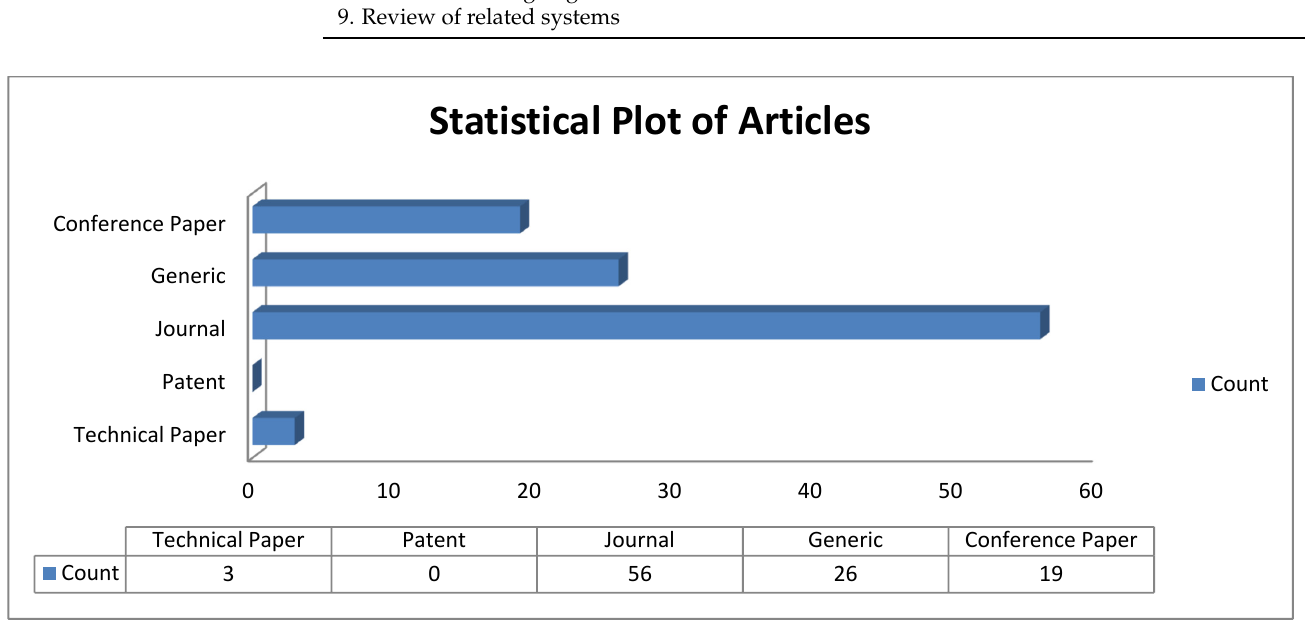
Figure 2. Statistical Plot of Articles .